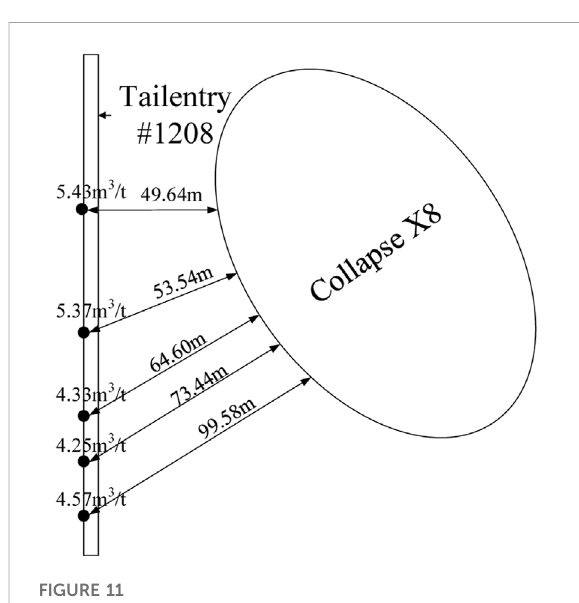
FIGURE 11 Gas occurrence rule around collapse column X8.